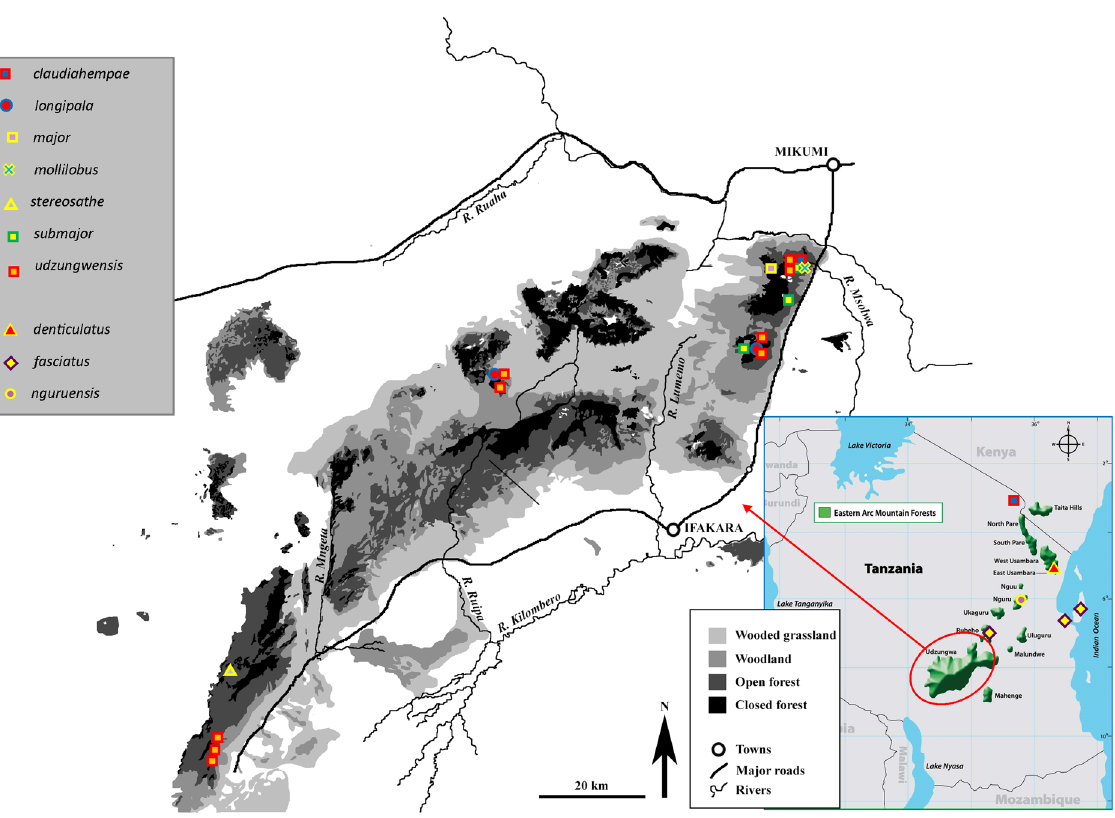
Fig. 1. Collecting sites for Aquattuor spp. in the Udzungwa Mts. Based on Marshall et al. (2010: fig. 1); inset by permission of the Eastern Arc Mountains Conservation Endowment